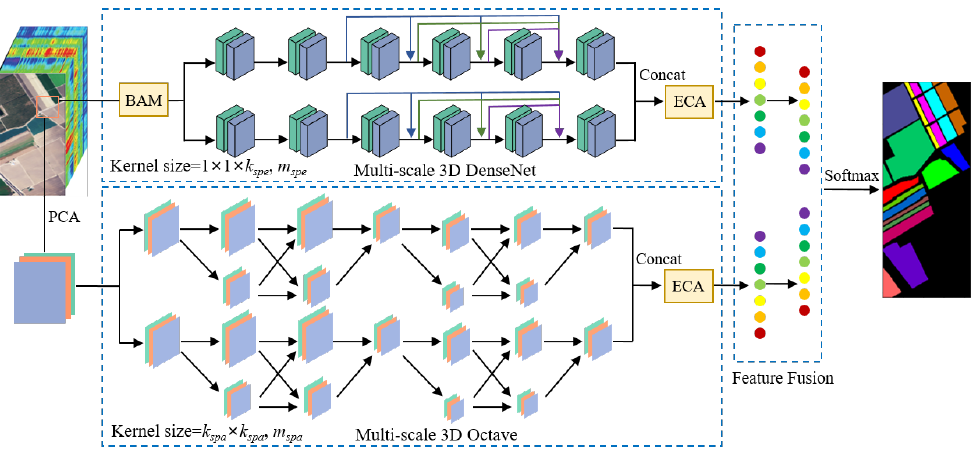
Figure 1. The flowchart of the network of the MOCNN approach for HSI